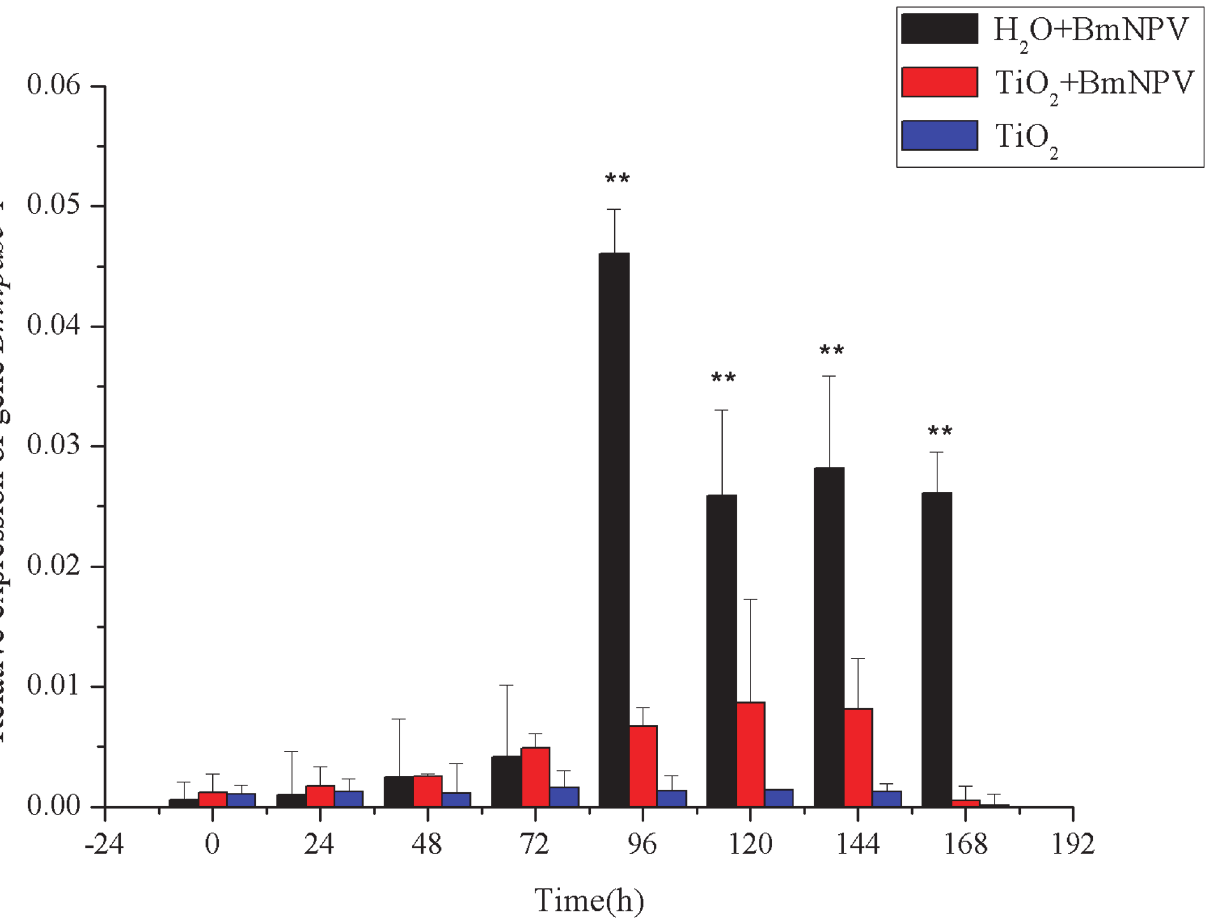
Fig 6. Relative expression of Bmlipase-1 . Black and red histograms represent the control group and the experimental group, respectively, and blue histograms represent the TiO 2 NPs-treated group. X and Y axes represent the time after infection and the relative expression of Bmlipase-1 , respectively. The bars in the figure with different letters indicate statistically significant differences ( p < 0.05).